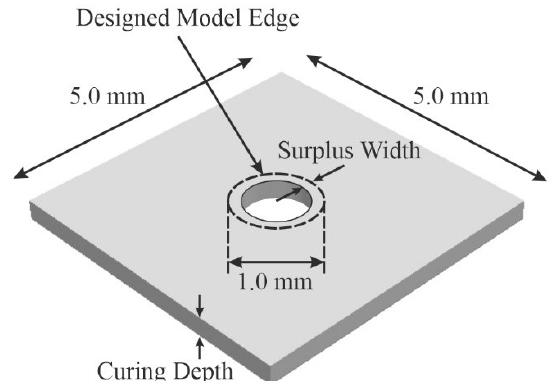
Figure 3. A lithographic test pattern to systematically optimize the laser drawing conditions. A round hole (1.0 mm in diameter) was opened at the center of a square sheet (5.0 mm in edge length). The hole diameters and sheet thicknesses were defined as the dimensional tolerances and curing depths, respectively.